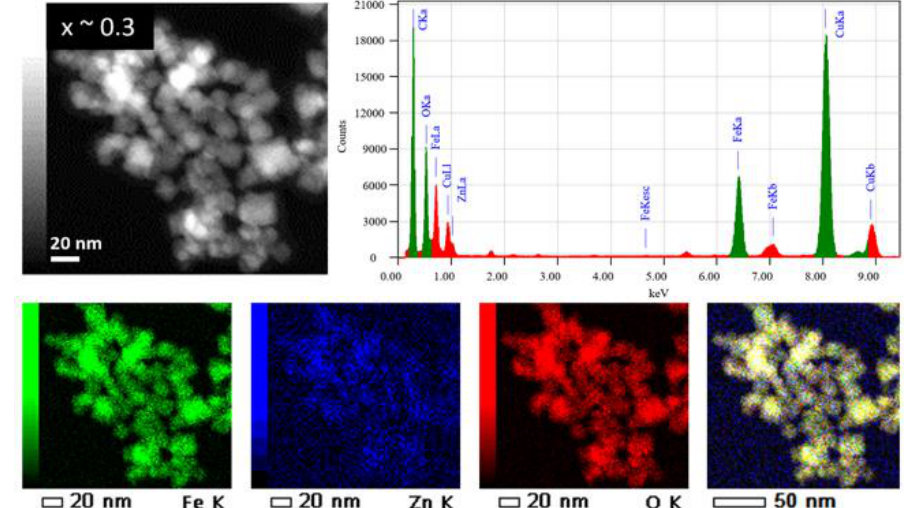
Figure 4. (Upper panels) TEM image of Zn x Fe 3−x O 4 MNPs with x ~ 0.3 and the corresponding EDX spectrum (C and Cu signals from the TEM grid are also observed). (Lower panels) from left to right: chemical maps of Fe, Zn, O and a global chemical map with the distribution of the 3 elements (Fe, Zn and O).